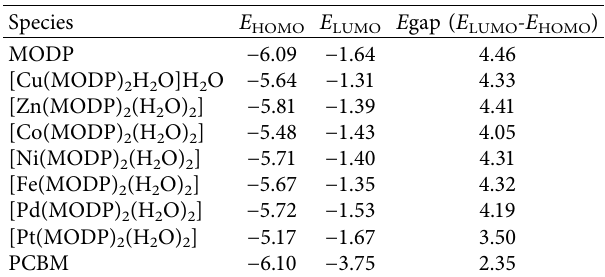
Table 4: The EHOMO, ELUMO, and Egap values of the studied molecules and PCBM calculated at PBE0-D3(BJ)/def2-TZVP theory of level in the gas phase, all in